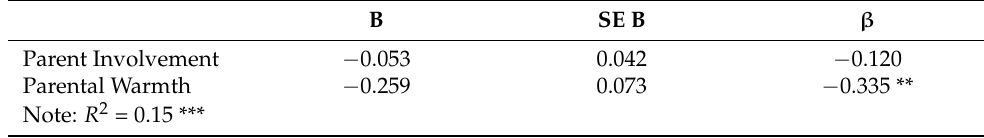
Table 6. Regression for girls—behavior problems.